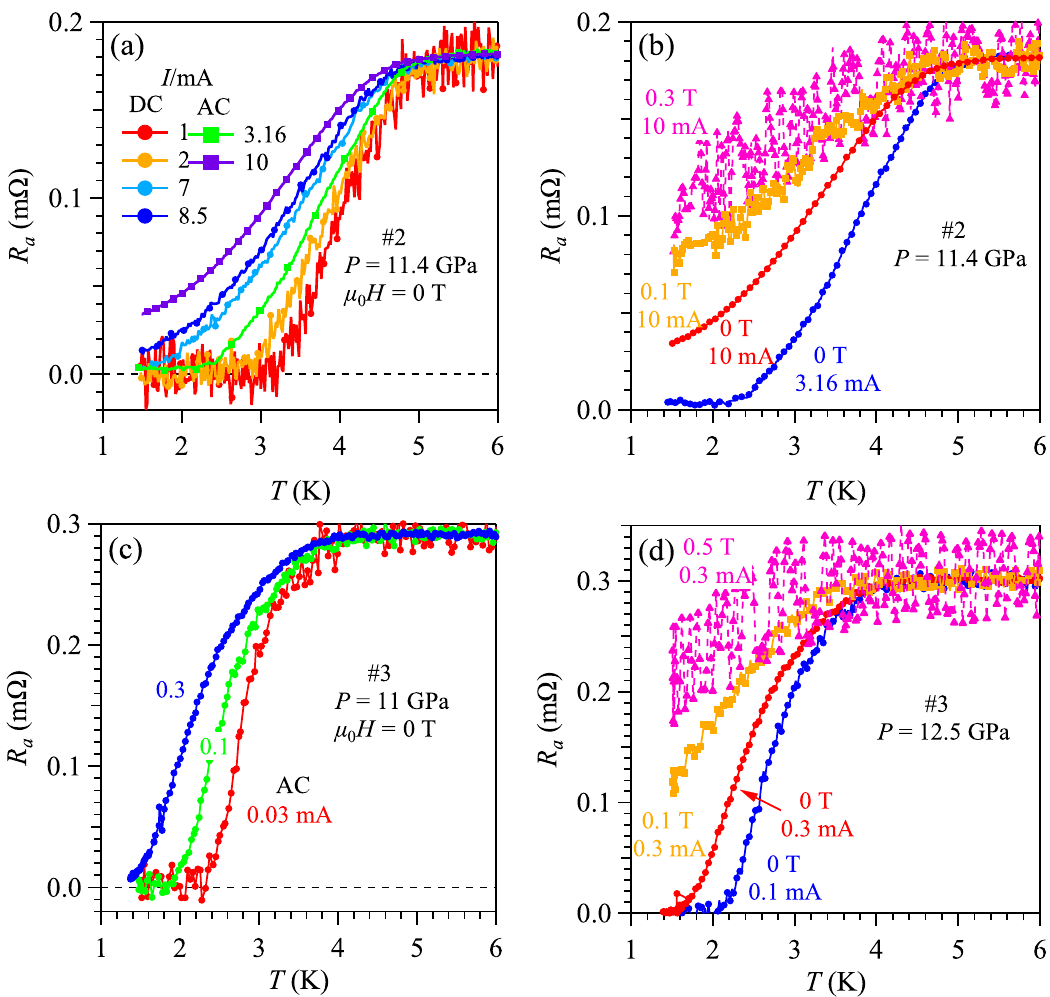
Fig. 4 The low-temperature a -axis resistance under high pressure. The low-temperature R a ( T ) for sample #2 at 11.4 GPa was measured with a different currents and b magnetic fi elds. c The low-temperature R a ( T ) for #3 at 11 GPa was measured with different currents. d The low- temperature R a ( T ) for #3 at 12.5 GPa measured with different currents and/or magnetic fi